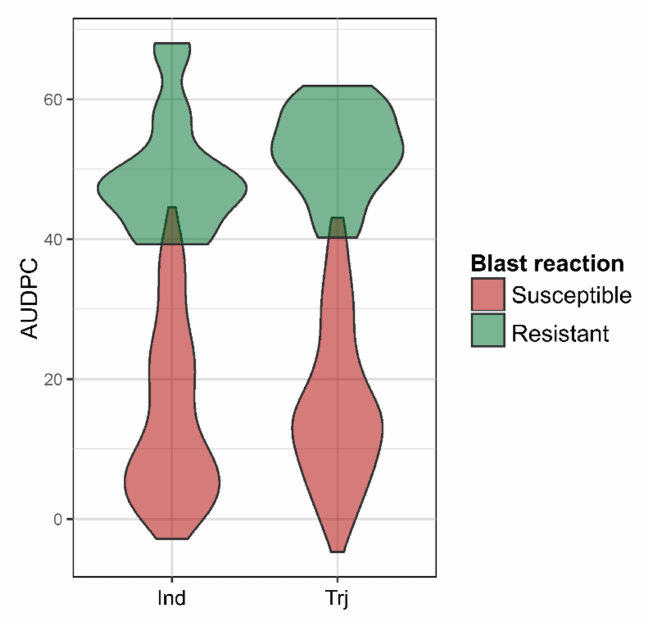
Figure 1. Distribution of the area under disease progress curve (AUDPC) in the indica (Ind) and tropical japonica (Trj) subpopulations according to their blast reaction rated at 7, 14, and 21 days post inoculation, with the rates equal to or below 3 as resistant, and at least one rate higher than 3 as susceptible